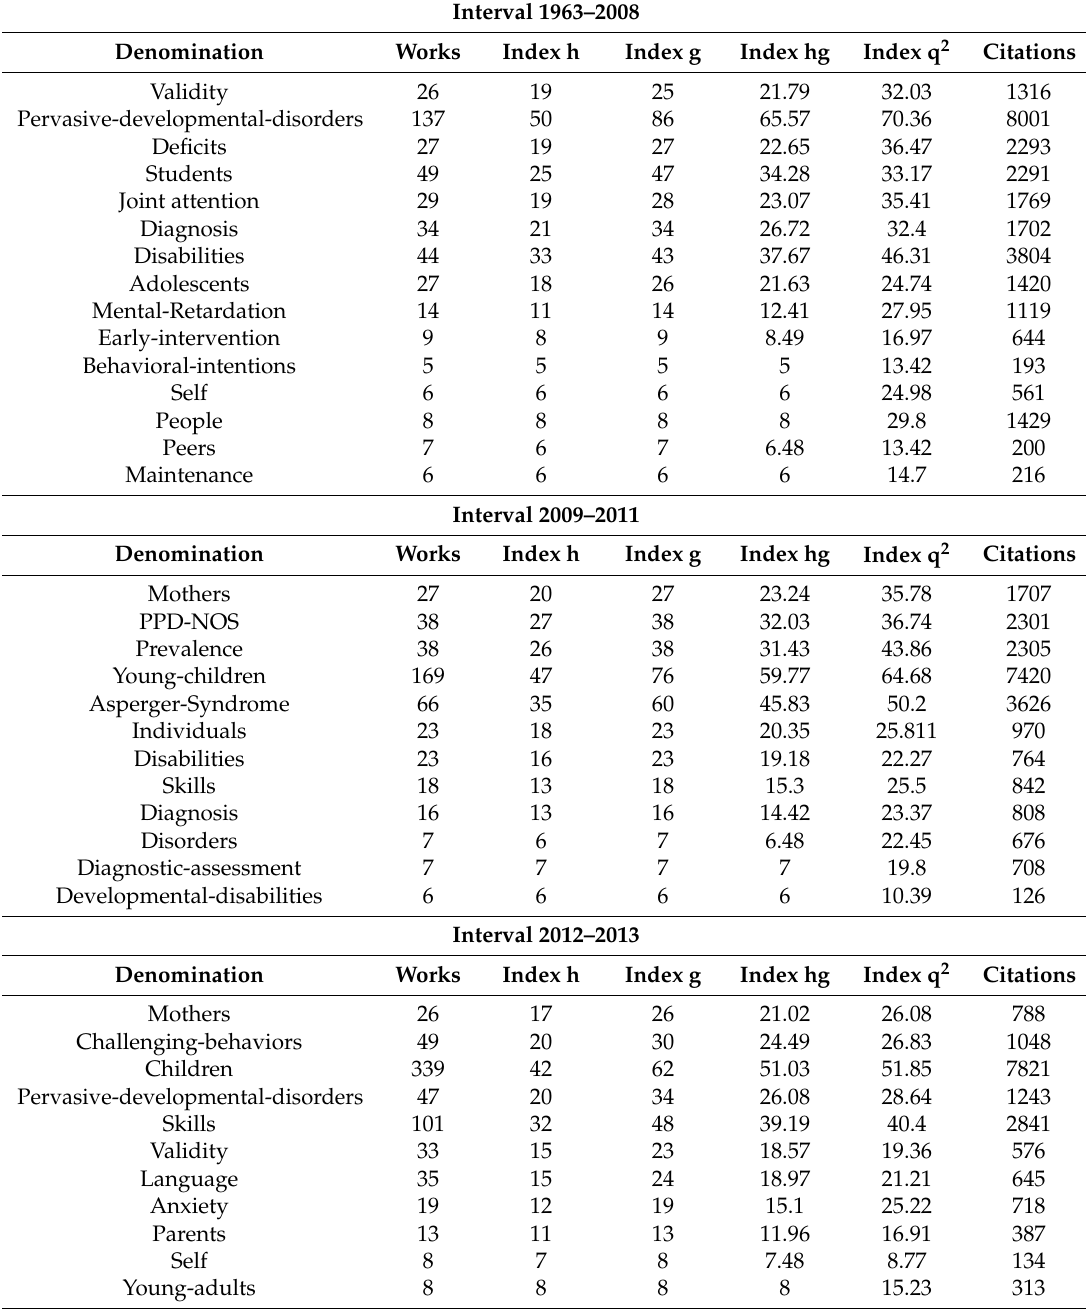
Table 10. Thematic performance in autism in the educational field